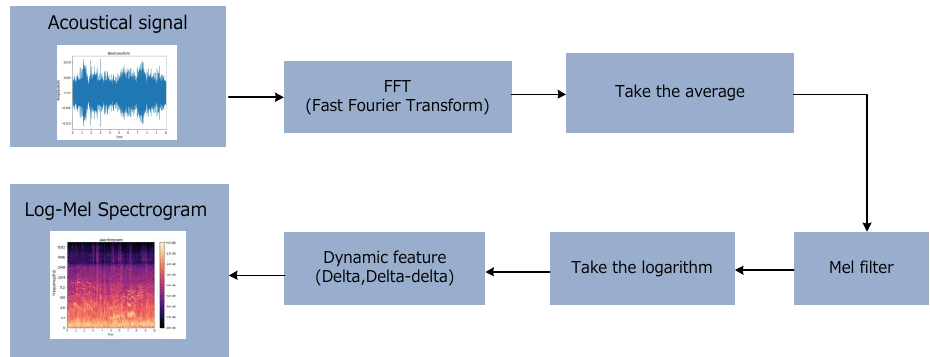
Figure 2. The acquisition of log-Mel spectrogram. After a series of operations, such as the fast Fourier transform, taking the average, Mel filter, logarithm, and extraction of dynamic features, the log-Mel spectrogram features of the acoustic signal data are obtained as the form of (frequency, time_steps, channel).